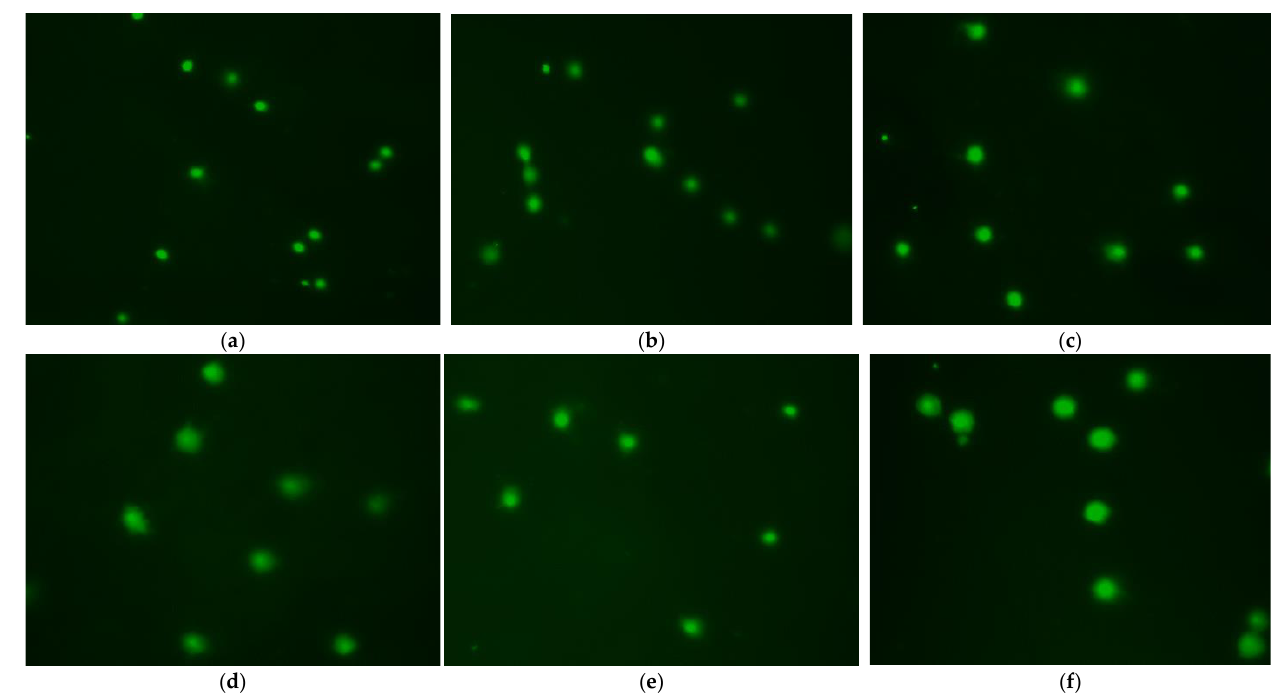
Different lowercase letters indicate significant differences among CPAs. Control: fresh sperm; PG: propylene glycol; EG: ethylene glycol.